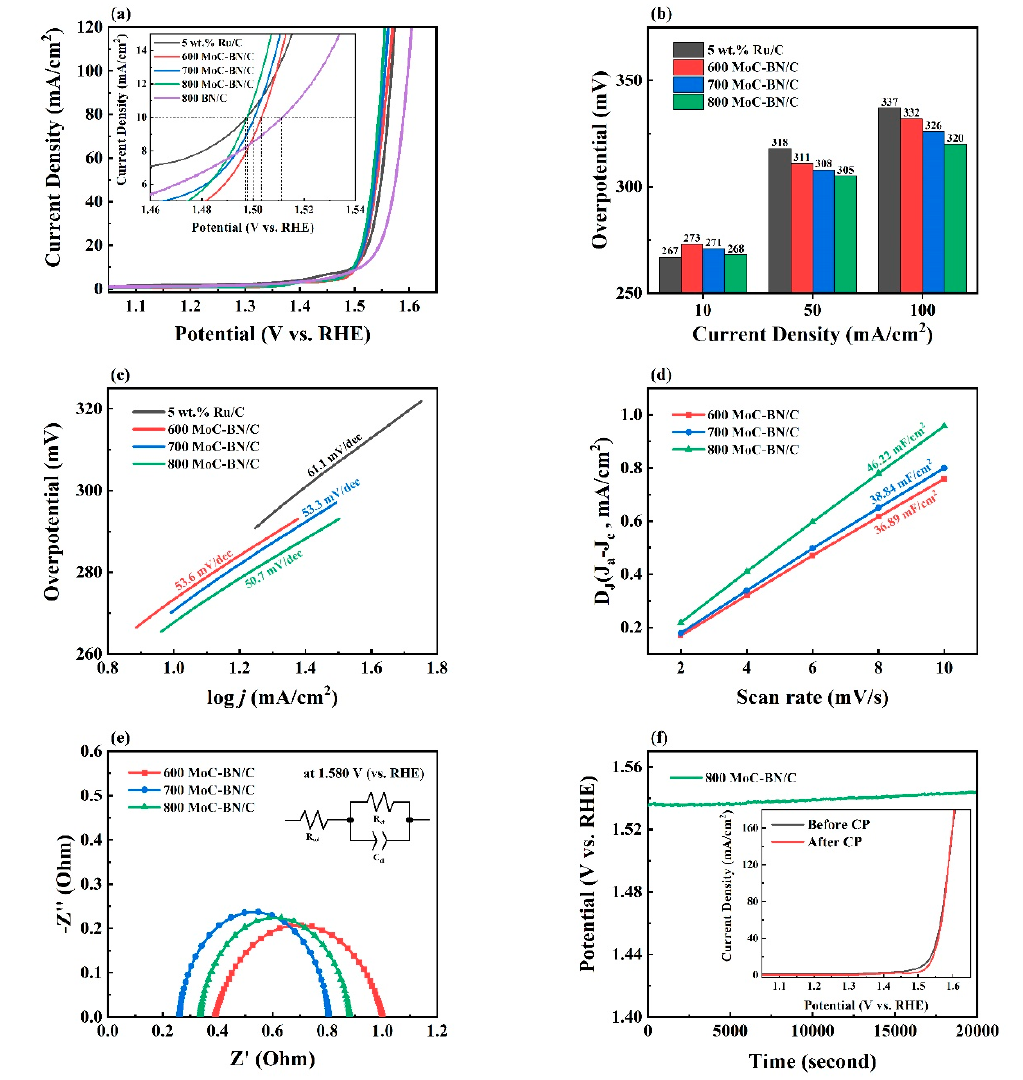
Figure 4. ( a ) Linear sweep voltammetry (LSV) curve of MoC-BN / C at 5 mV / s in N 2 saturated 1M KOH, ( b ) overpotential at 10, 50, and 100 mA / cm 2 for OER, ( c ) correlated Tafel slope from each LSV curve, ( d ) plotted graph at 0.99 V (vs. RHE) from cyclic voltammetry (CV) graphs conducted with several scan rates, ( e ) Nyquist plots obtained by electrochemical impedance spectroscopy (EIS) at 1.580 V (vs. RHE), and ( f ) chronopotentiometry (CP) curve of 800 MoC-BN / C at 10 mA / cm 2 for 20,000